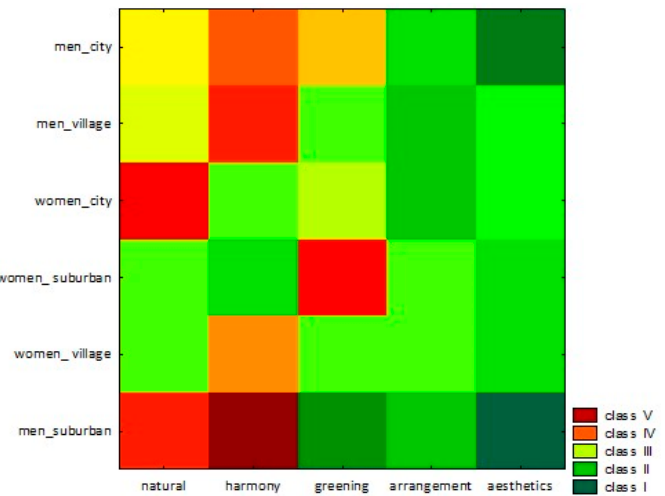
Figure 8. Standardized assessment of the harmonious landscape with respect to the five most common characteristics depending on the gender and place of residence (EnvEng and CivEng students combined, n = 244).